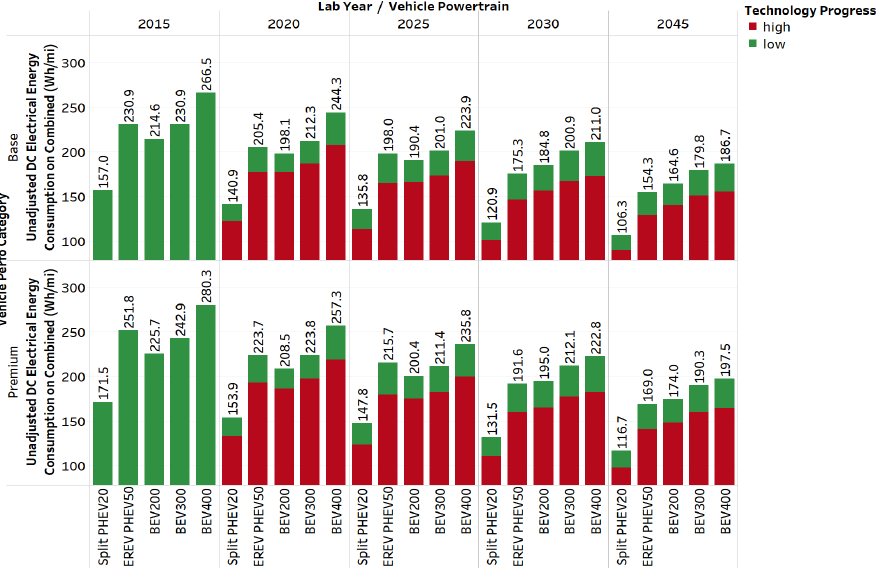
Figure 11. Unadjusted direct current (DC) electrical energy consumption on combined driving cycle (Wh/mile) for midsize